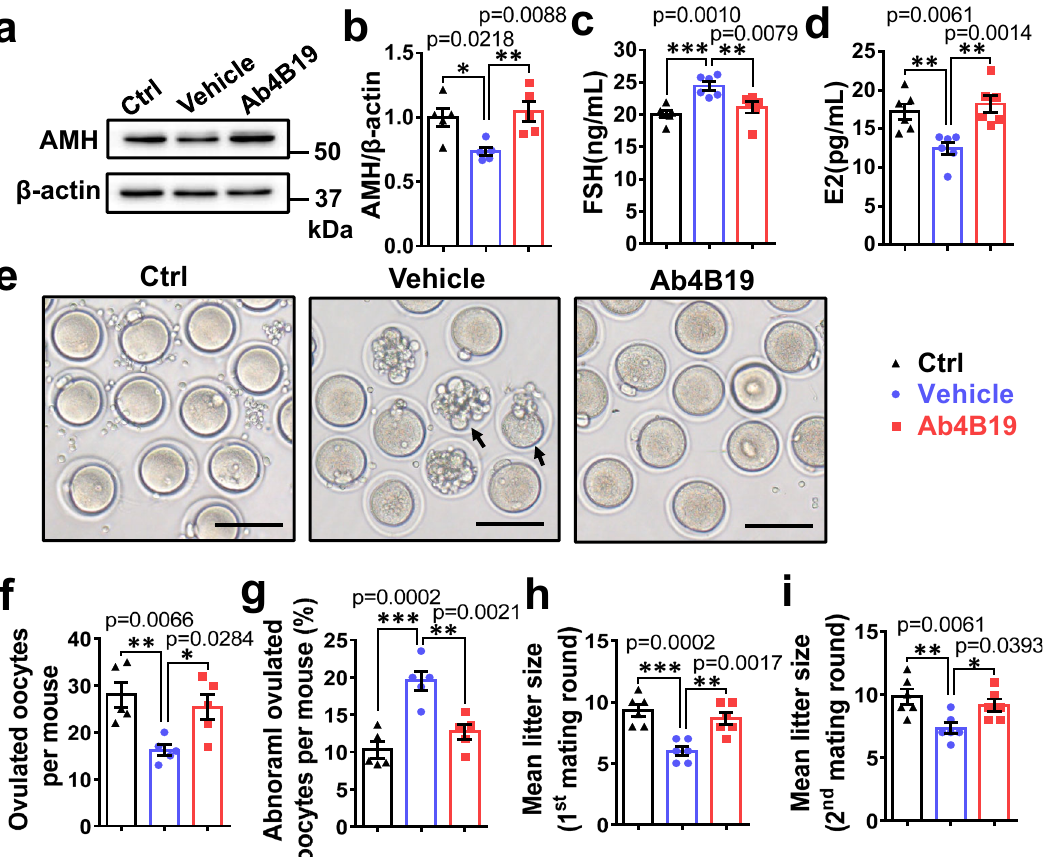
Fig. 6 Improvement in fertility by Ab4B19 in Cy-POF model. a Regulation of AMH expression by Cyclophosphamide and Ab4B19 in the mouse ovary. Cy- POF mice were treated with Ab4B19 as shown in Fig. 5a. The lysates of ovarian tissues from three groups, control (Ctrl), Cy-POF mice treated with or without Ab4B19 (saline solution, or normal IgG, Ab4B19) were processed for Western blotting to detect the expression of AMH. b Quanti fi cation of AMH expression levels (ratio to β -actin). The levels of the control group were normalized to 1. N = 5 mice per group. Levels of FSH ( c ) and estradiol (E2) ( d ) were measured by ELISA from the sera collected from the three groups. ( N = 6 mice per group). e Representative photomicrographs of oocytes from the three groups. Note that there were more abnormal oocytes in Cy-POF (vehicle) group than the control group, and treatment with Ab4B19 rescued the de fi cit. Black arrow: abnormal oocytes. Scale bar, 150 μ m. f Quanti fi cation of the ovulated oocytes per mouse in each treatment group. ( N = 5 mice per group). g Abnormal oocytes. The percentage of abnormal oocytes/total ovulated oocytes per mouse was calculated for each treatment group. ( N = 5 mice or normal IgG ( N = 6 mice per group). i Mean litter size in the second round of mating, measured for the same female mice ~5 weeks after the fi rst-round parturition ( N = 6 mice per group). Data were all presented as mean ± SEM. Statistical analyses were carried out using one-way ANOVA followed by